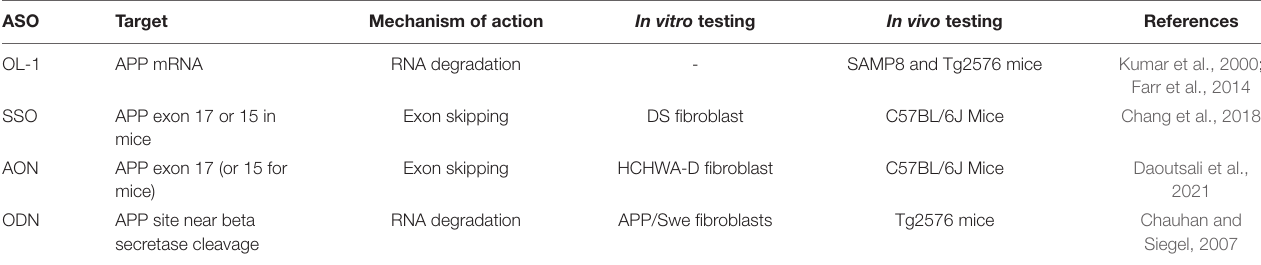
TABLE 1 | Summary of antisense oligonucleotide (ASO) knockdown studies to date. ASO